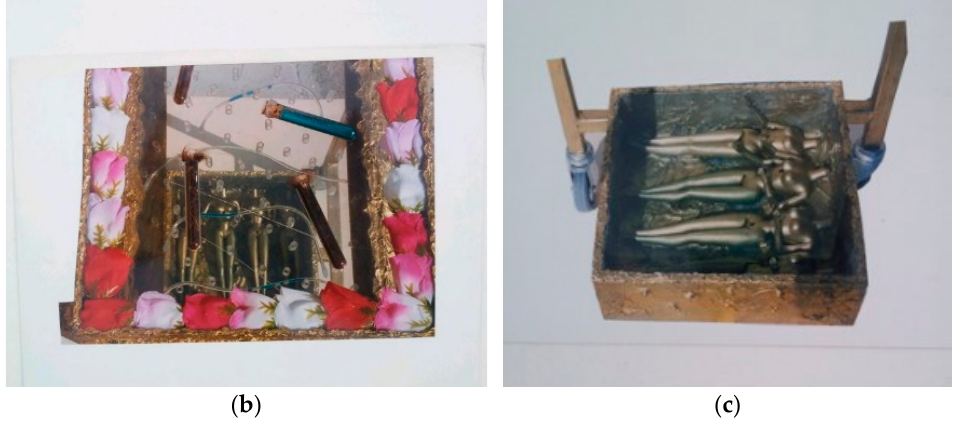
Figure 7. ( a ) Anat Massad, Untitled, 1994, hair, test tubes, and mixed technique, 90 × 50 × 43 cm, the artist’s collection (above); ( b ) Detail (bottom right); ( c ) Detail (bottom left). Courtesy of Anat Massad.